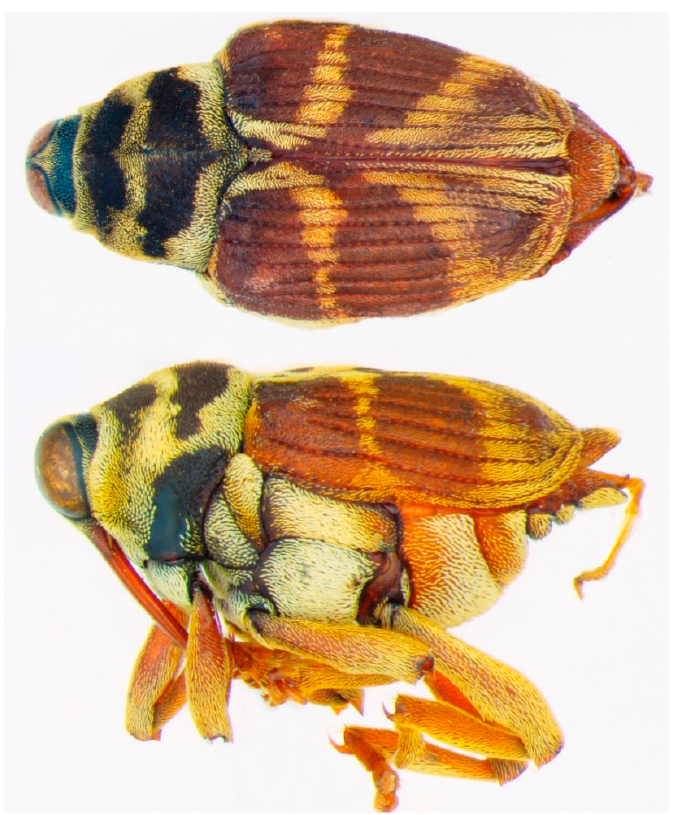
Figure 2. Philenis anzaldoi , dorsal and lateral habitus.